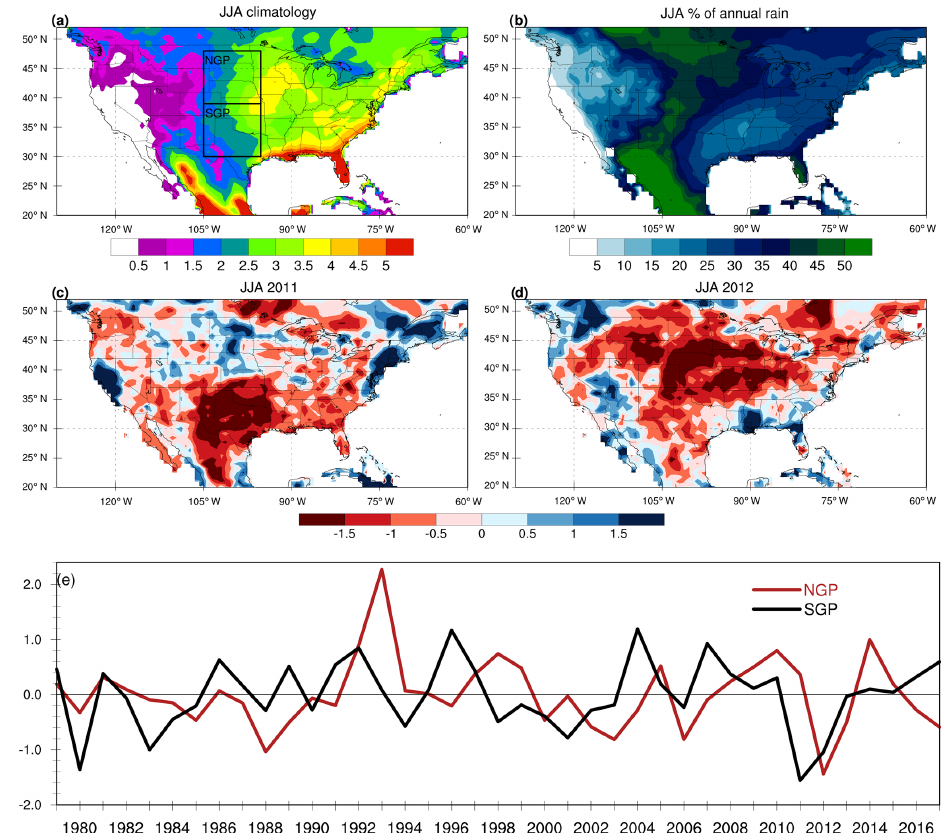
Figure 1. Spatial maps of JJA precipitation (a) climatology (mmd − 1 ), (b) JJA’s percentage of the annual rain rate, and standardized anomalies (dimensionless) for the extreme droughts of (c) 2011 and (d) 2012. Monthly time series of the standardized anomalies of JJA precipitation are also shown (e) for the southern GP and northern GP regions (denoted by the boxes in a ). The climatology and standardized anomalies were calculated using the CPC precipitation over the 1979–2018